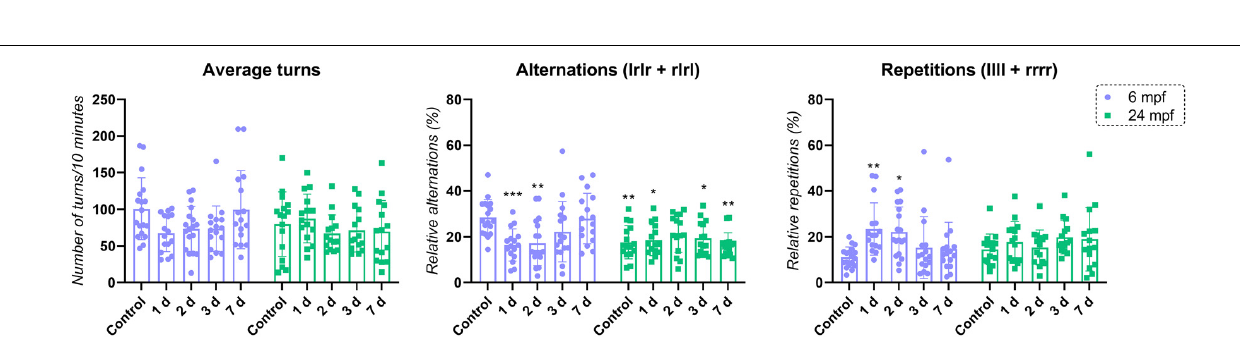
FIGURE 3 | Comparison between age and MS222 effects. Data were represented as mean ± S.E.M and analyzed using two-way ANOVA followed by Tukey’s post hoc test. Asterisk represents significant differences compared to control 6 mpf ( p* < 0.05; p** < 0.005 and p ∗∗∗ < 0.0005; n = 15–18 per